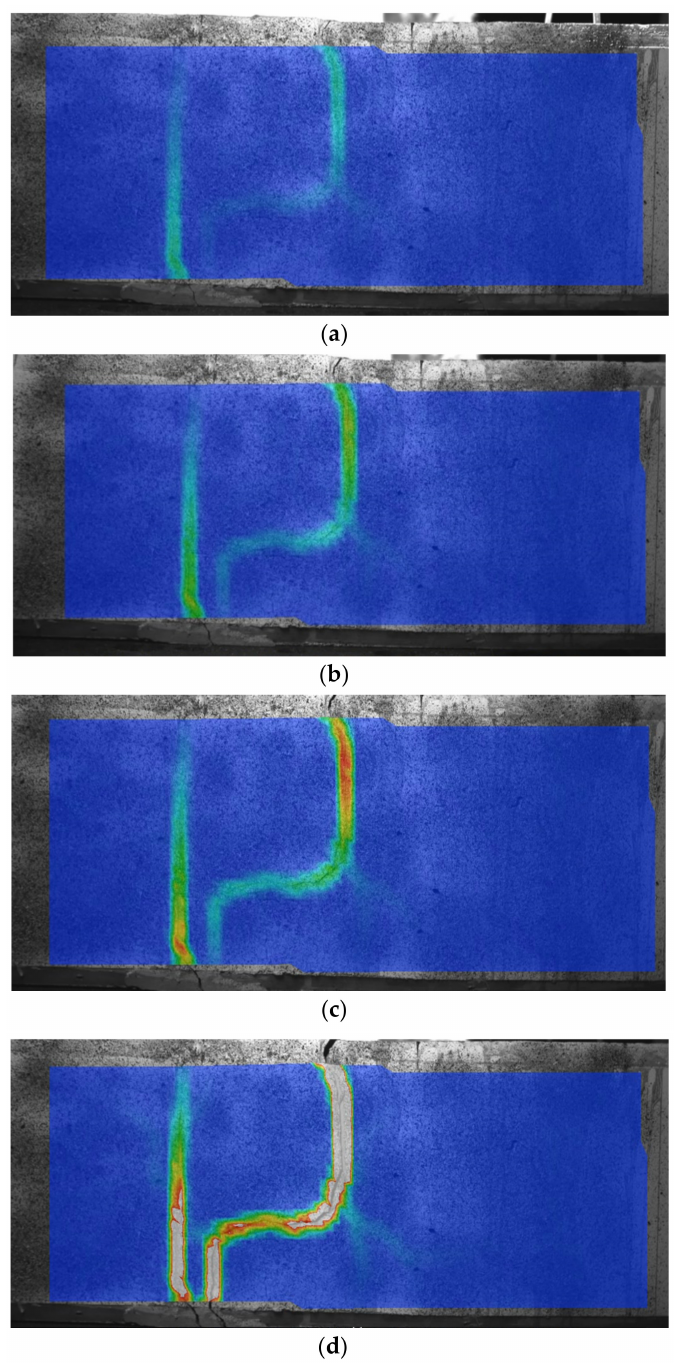
Figure 10. Displacement distributions in joint J100-SB-SP at characteristic loads: ( a ) 470 kN (initial cracking); ( b ) 600 kN (extensive cracking); ( c ) 750 kN (accelerated cracking); ( d ) 800 kN (final